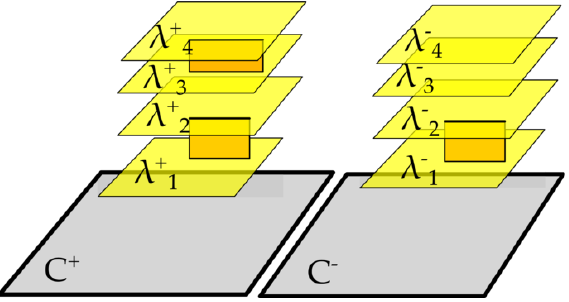
Figure 12 . Each of the building blocks X (cid:6) de(cid:12)nes a spectral cover over C (cid:6) , and these are then glued to a spectral cover over S 3 . In the example shown here, the cover on C + factors into two components and the cover on C (cid:0) factors into three components. These covers are glued such that the resulting spectral cover over S 3 has two components with two sheets each. Hence the resulting model has G ? = S [U(2) (cid:2) U(2)] and there is a single unbroken